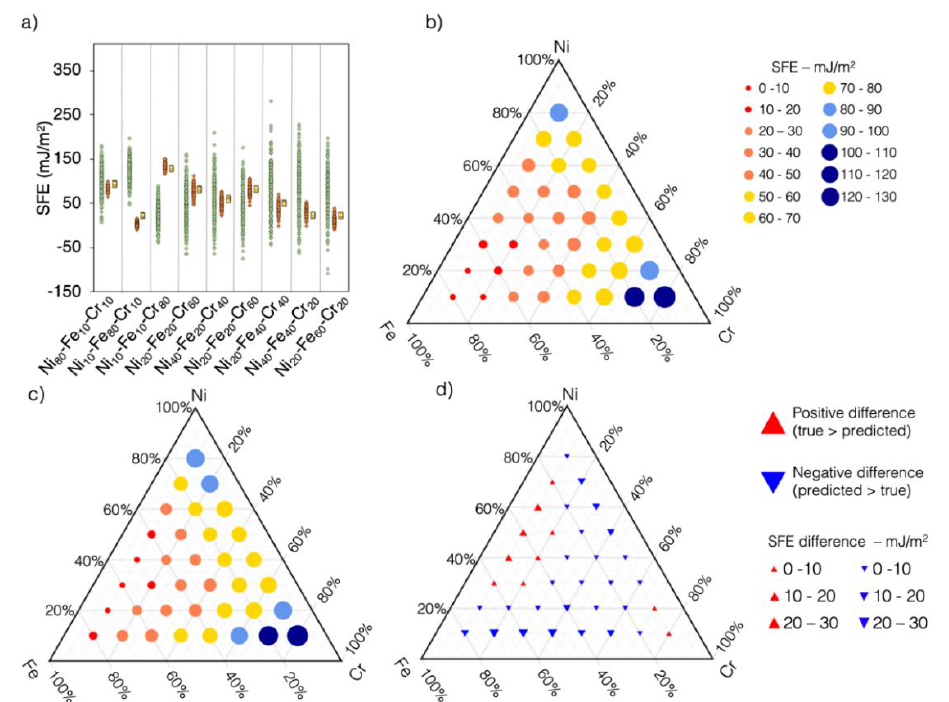
Figure 11. ( a ) SFE comparison between true-data for 480-atom and predicted-data for 12,000-atom supercells for nine di ff erent Ni-Fe-Cr ternary composition. True data for the 480-atom and 12,000-atom system is shown in green and brown color diamonds, while predicted data for 12,000-atom system in shown by yellow squares. Significantly reduced SFE variation is observed in both 12,000-atom ML-predicted compared to 480-atom true supercells. ( b ) True and ( c ) predicted SFEs in ternary Ni-Fe-Cr phase diagram. ( d ) Di ff erence between true and predicted SFE from ( b ) and ( c ) for each composition. Very small di ff erence between the two is observed illustrating the robustness of the ML model .